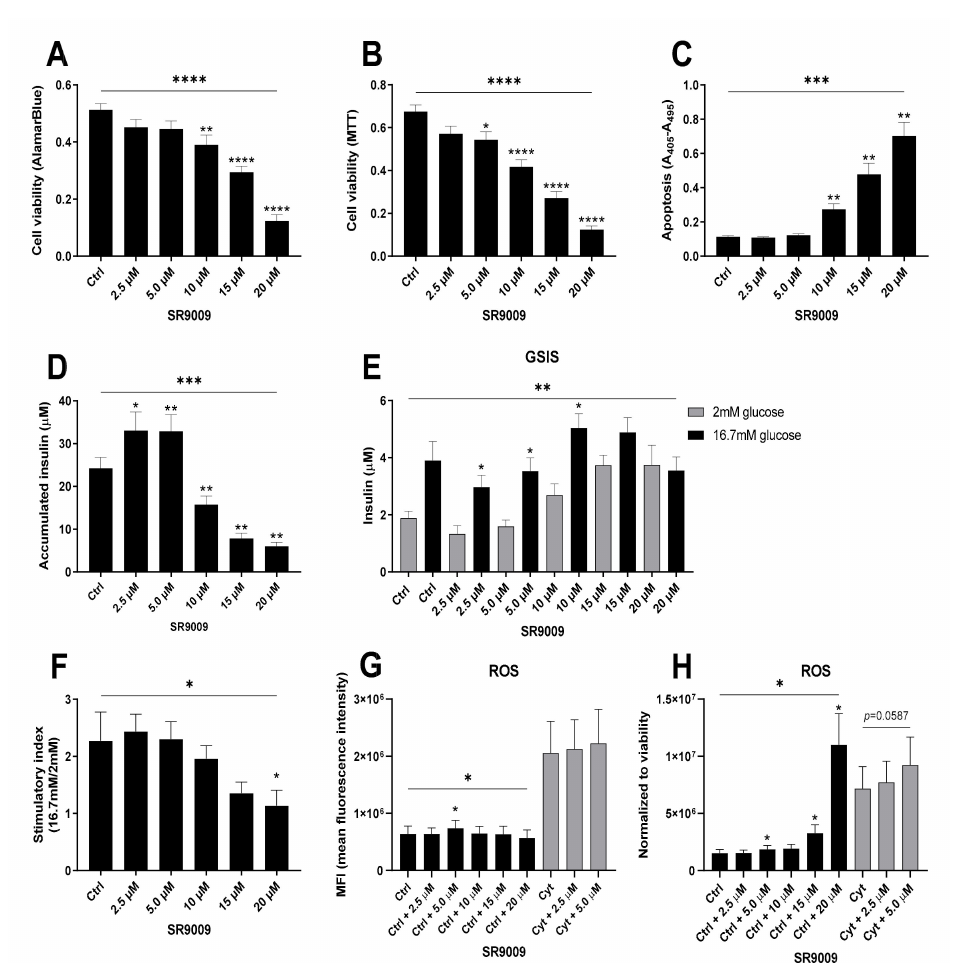
Figure 5. SR9009 reduces viability and function in a reactive oxygen species (ROS)-dependent manner in non-synchronized INS-1 cells. INS-1 cells were exposed to increasing concentrations of SR9009 alone or in combination with 150 pg/mL mouse IL-1 β + 0.1 ng/mL rat IFN- γ (Cyt) for 24 h to assess the effect on cell viability ( A , B ), apoptosis levels ( C ), accumulated insulin ( D ), glucose stimulated insulin secretion (GSIS) ( E , F ) and ROS production ( G , H ). Values are mean ± SEM ( n = 6–12). Statistics are one-way ANOVA with p -values represented by symbols above the line and with Dunnett’s corrected multiple comparisons to Ctrl (black bars) or to Cyt (gray bars), or with Bonferroni corrected multiple comparisons between similar concentrations of SR9009 ( E ), and post hoc paired Student’s t -test ( F , G ). Significance levels were annotated as follows: * = p -value < 0.05, ** = p -value < 0.01, *** = p -value < 0.001, **** = p -value <